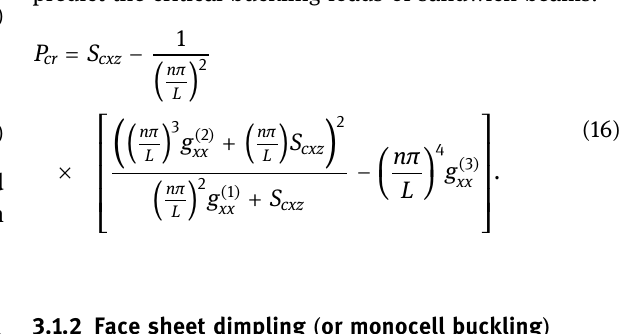
Face sheet dimpling is a type of instability of honeycomb sandwich panels in which a face sheet over one cell buckles like a small plate supported by the cell walls. The critical stress for face sheet dimpling can be calcu